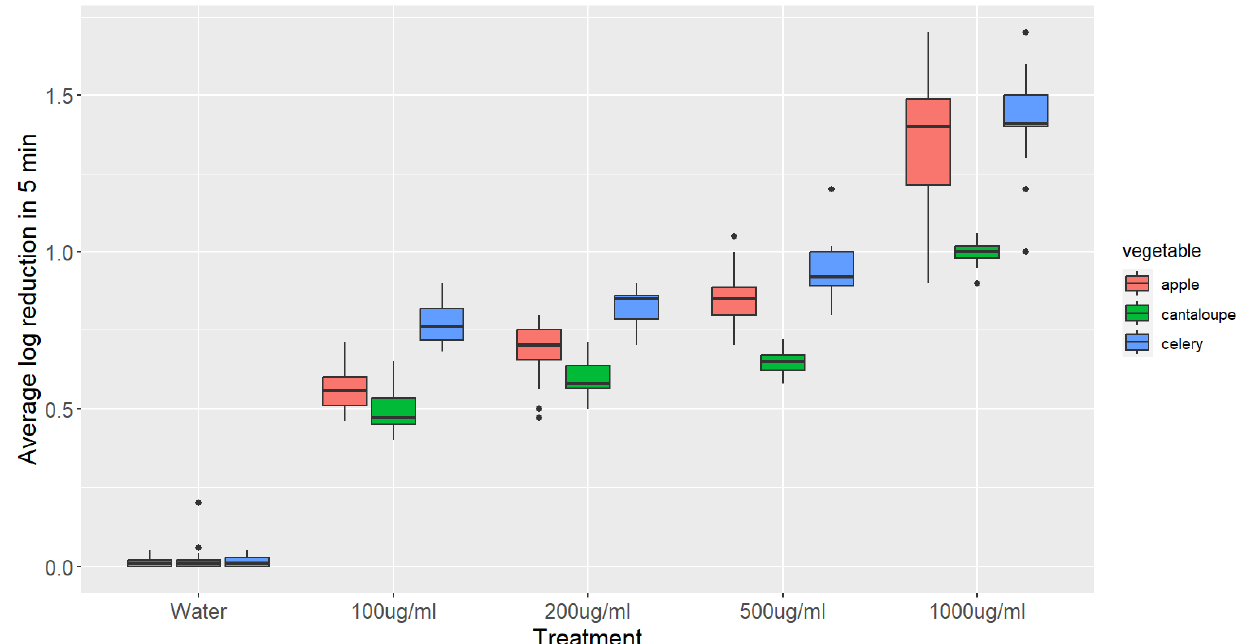
Figure 1. Boxplots showing the reduction in L. monocytogenes on different vegetables after 5 min treatment with various concentrations of GSE. The log reduction values were compared using an ANOVA, followed by a Tukey’s post hoc test. The boxplots represent the distribution of log reduction values for each treatment and vegetable, with the median, interquartile range, and range of values. The statistical analysis revealed that all of the log reductions were significantly higher than the control ( p -value < 0.05), and the log reduction in the 1000 µ g/mL treatment of apple was significantly higher than those in all other treatments ( p- value < 0.05).